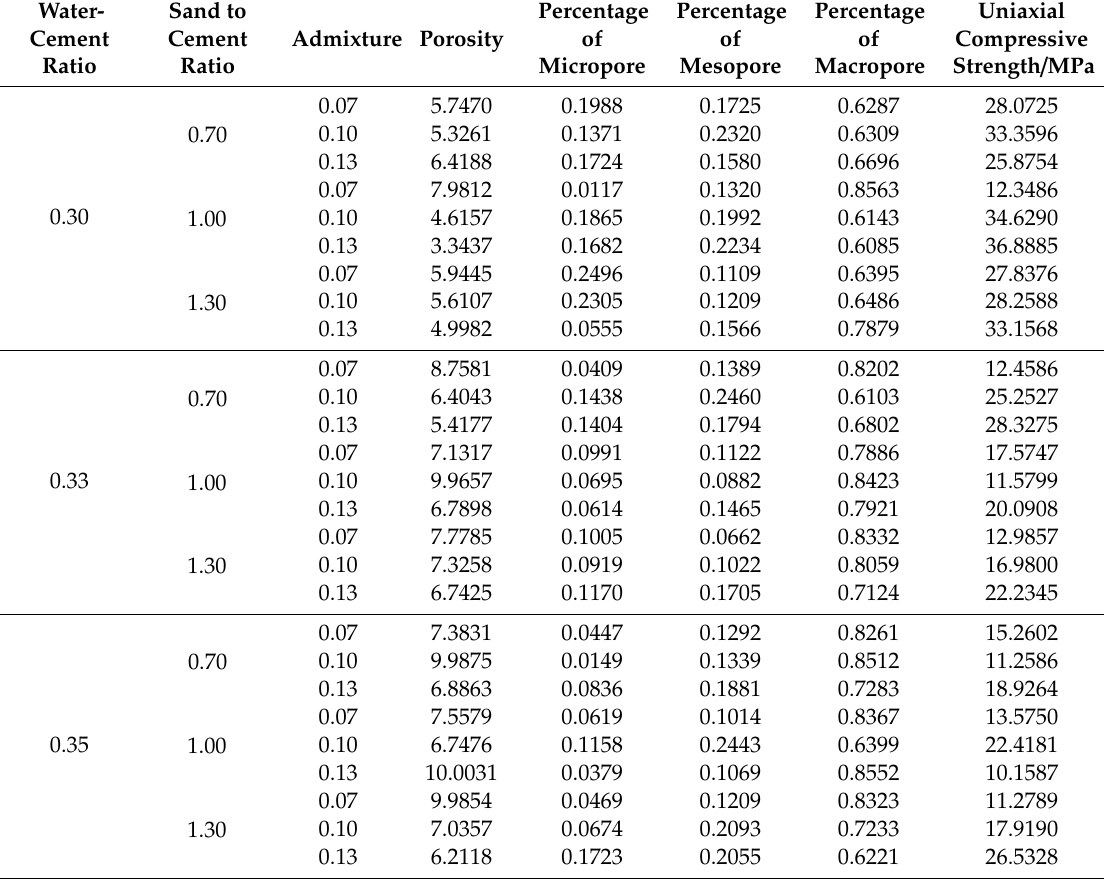
Table 4. Statistics of pore volume and compressive strength of